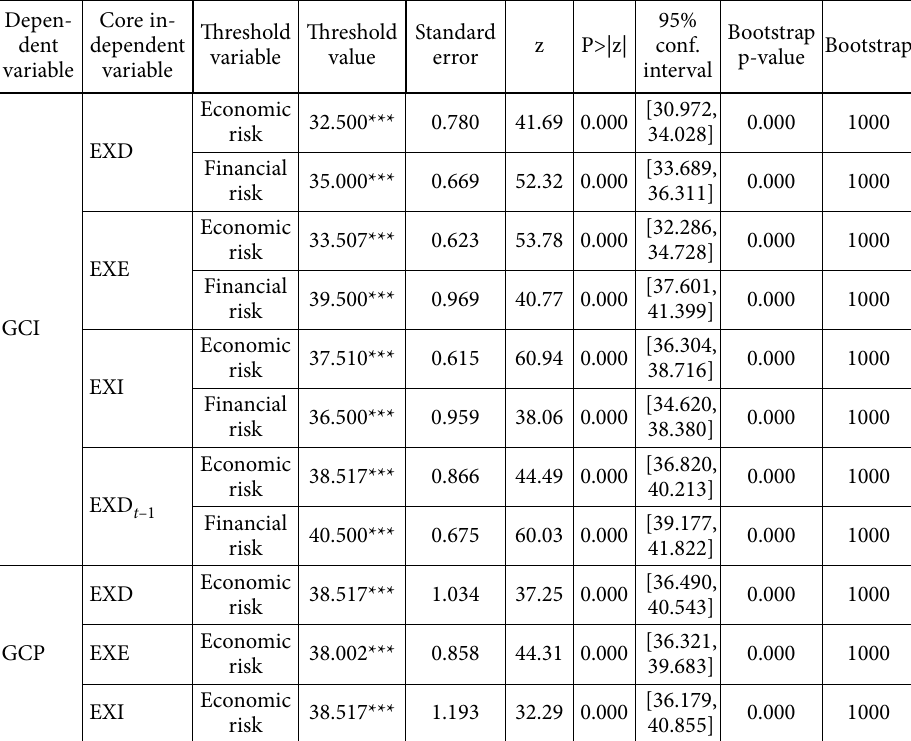
Table 5. Testing results for linearity and the threshold effect Depen- dent